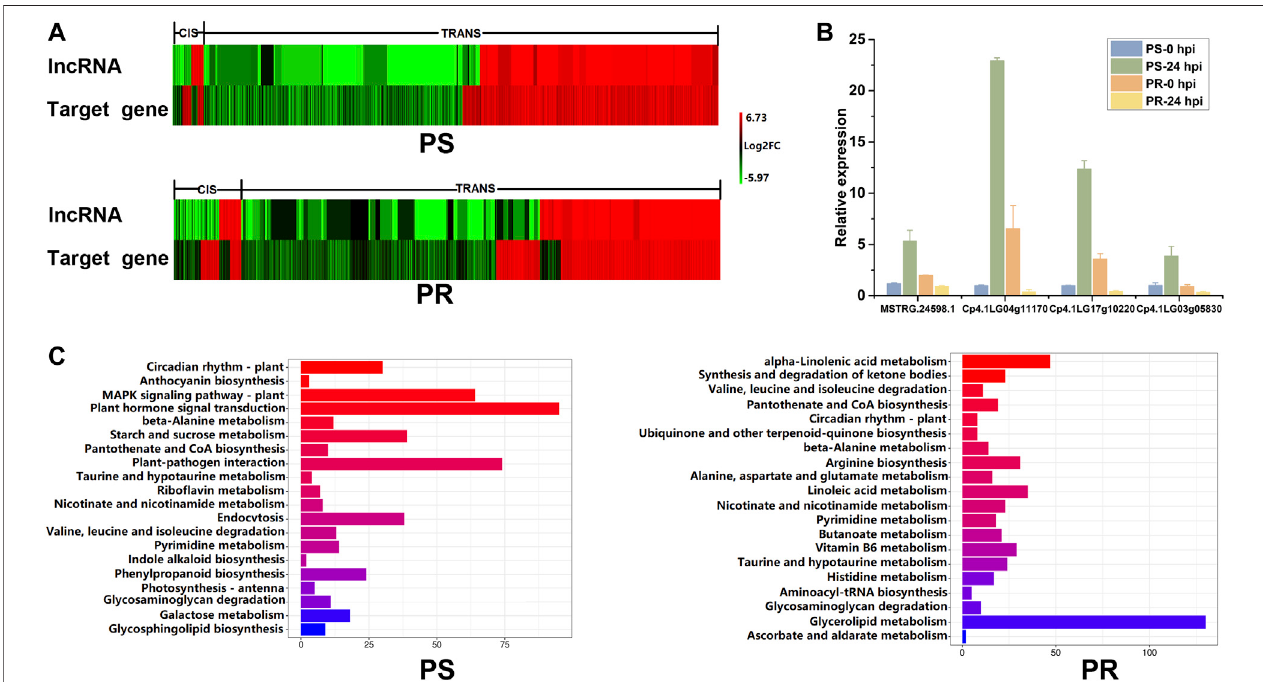
FIGURE 6 | Expression and function analysis of potential target genes of PM-responsive lncRNAs. (A) Expression relationship between PM-responsive lncRNAs and their potential target genes. Heat map representing the log 2 FC of expression levels of PM-responsive lncRNAs and their putative target genes at 24 h post PM inoculation. (B) Con fi rmation of the expression relationship of MSTRG.24598.1 and its three putative target genes using qRT-PCR. Error bars indicate standard deviations among three biological replicates ( n = 3). (C) Pathway enrichment analysis for the potential target genes of PM-responsive lncRNAs in PS and PR, respectively. The top 20 pathways were listed and shown. PS represents PM-susceptible C. pepo and PR represents PM-resistant C. pepo